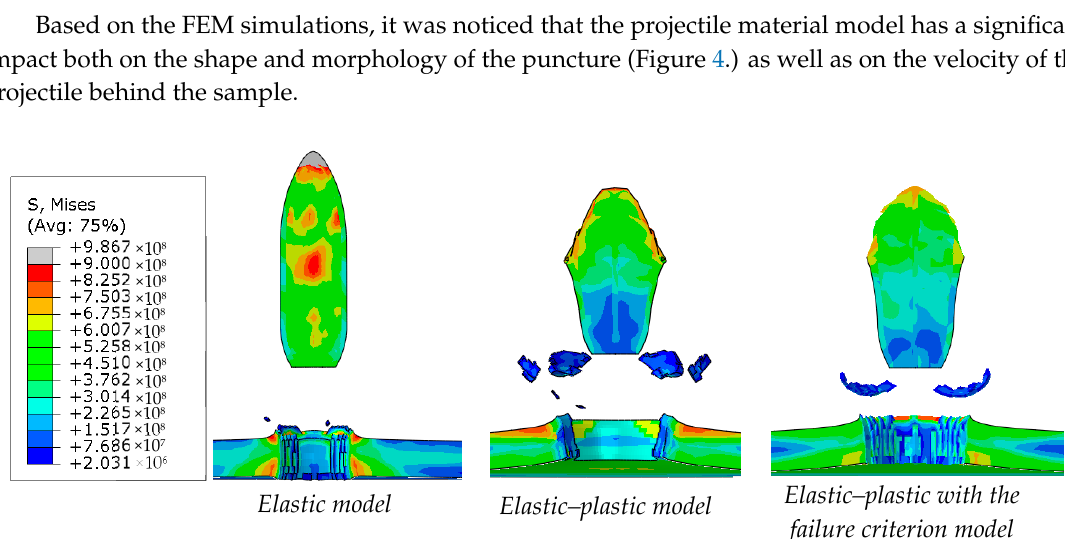
Table 4. Material properties for the shell and the bullet core [4].